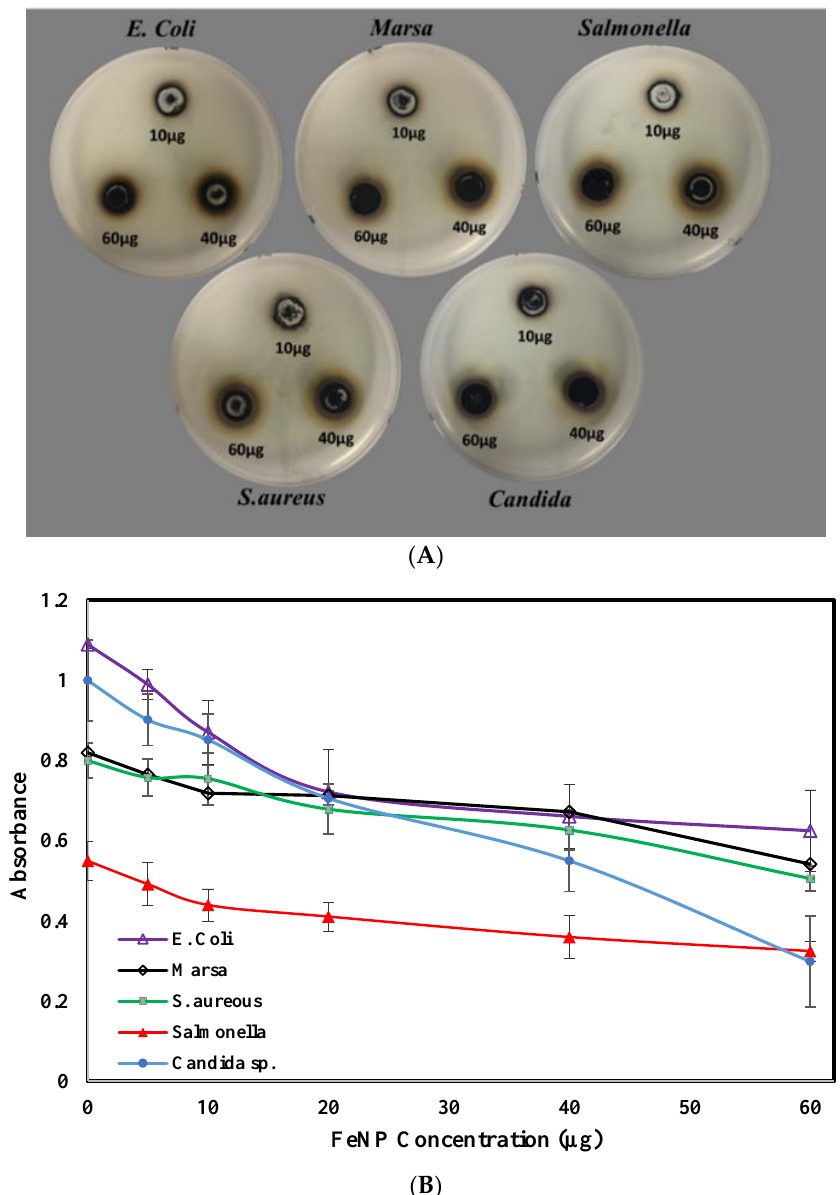
Figure 12. ( A ) Ability of the synthesized FeNP to inhibit the bacterial growth; and ( B ) growth profile of various pathogenic species inoculated against different concentrations of FeNP.